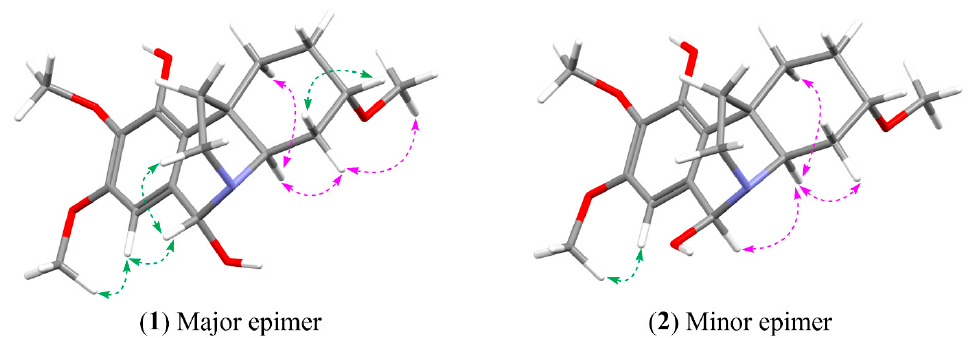
Figure 5. Selected NOESY correlations for two 6-epimers of 6-hydroxyhippeastidine. Green arrows: